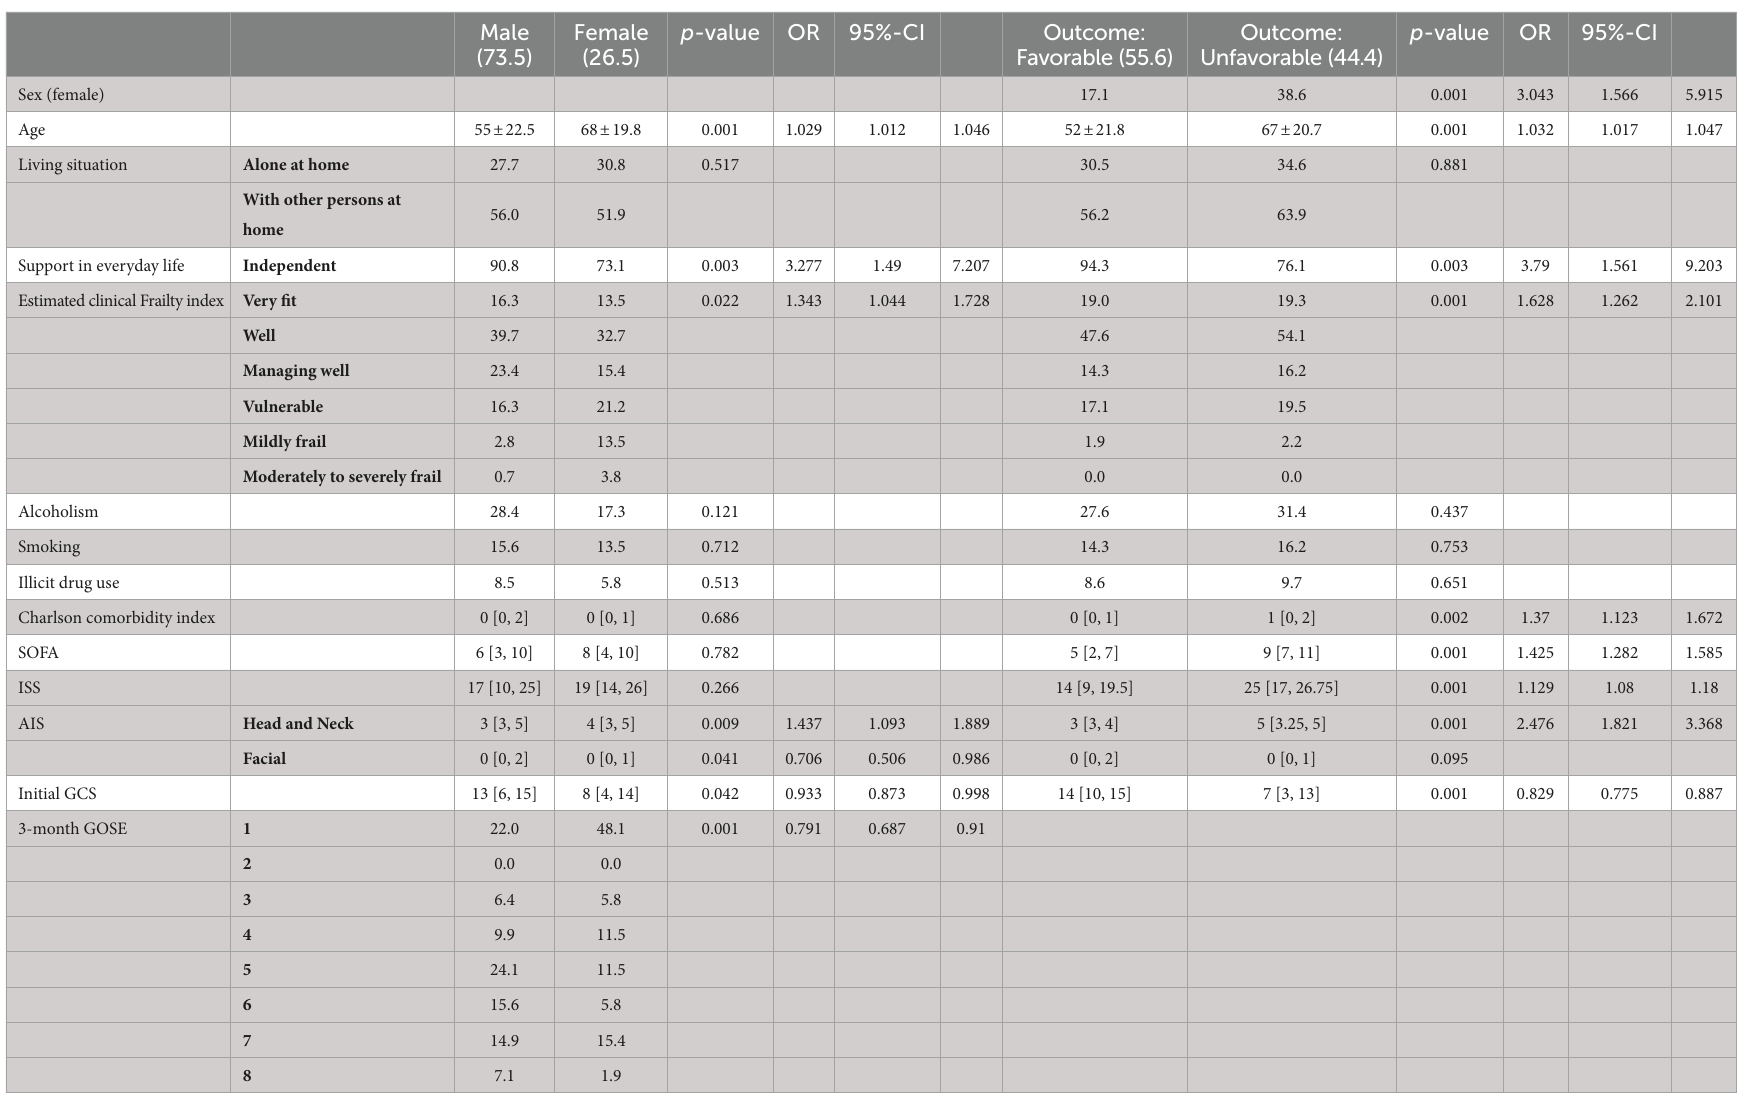
TABLE 2 Demographics dichotomized by sex and outcome (TBI